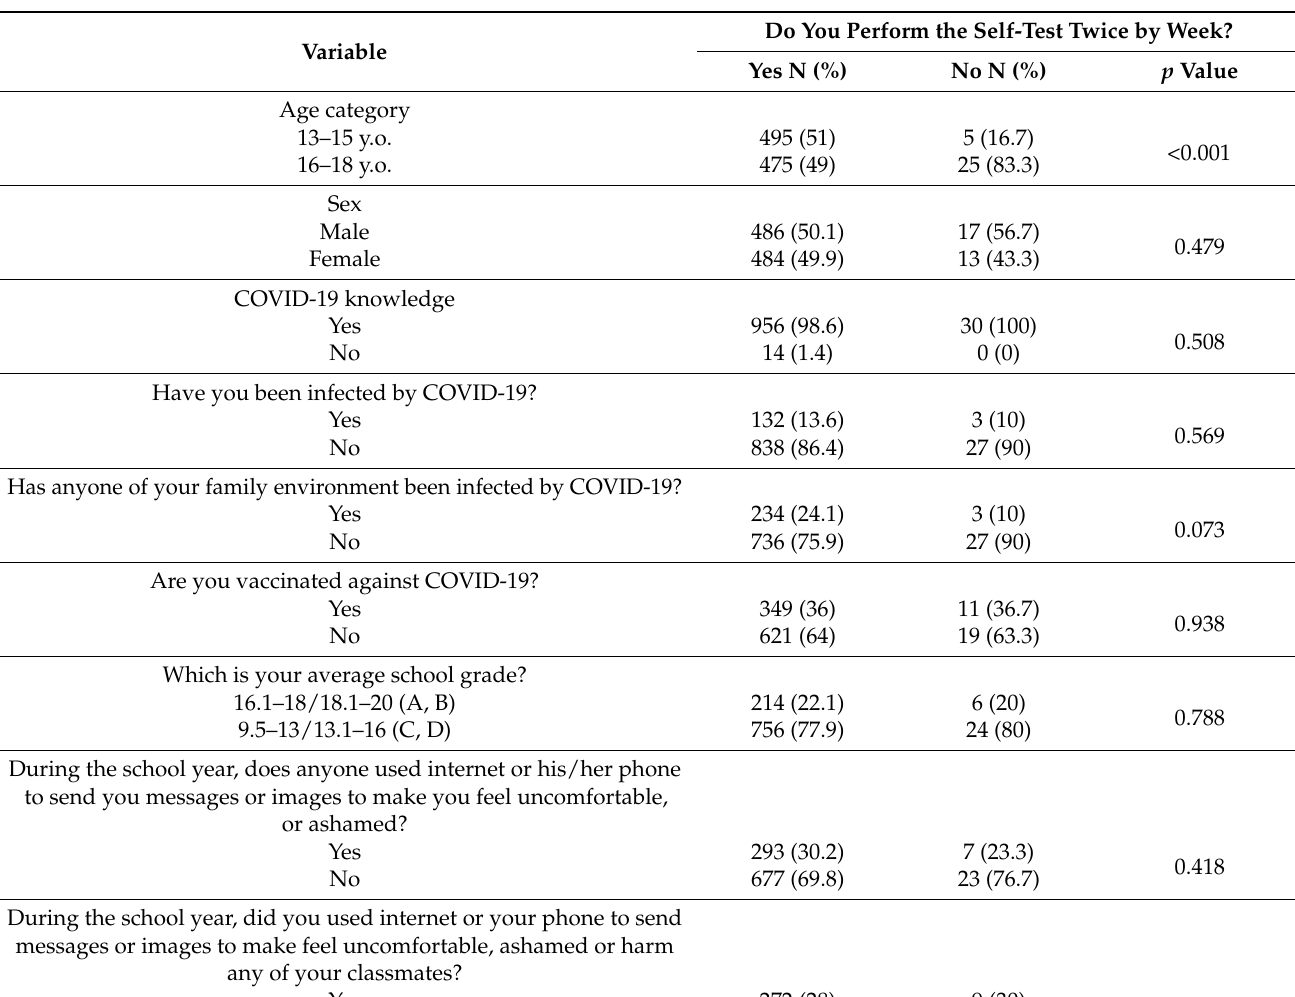
Table 4. Univariate analysis of performing the self-test for both age